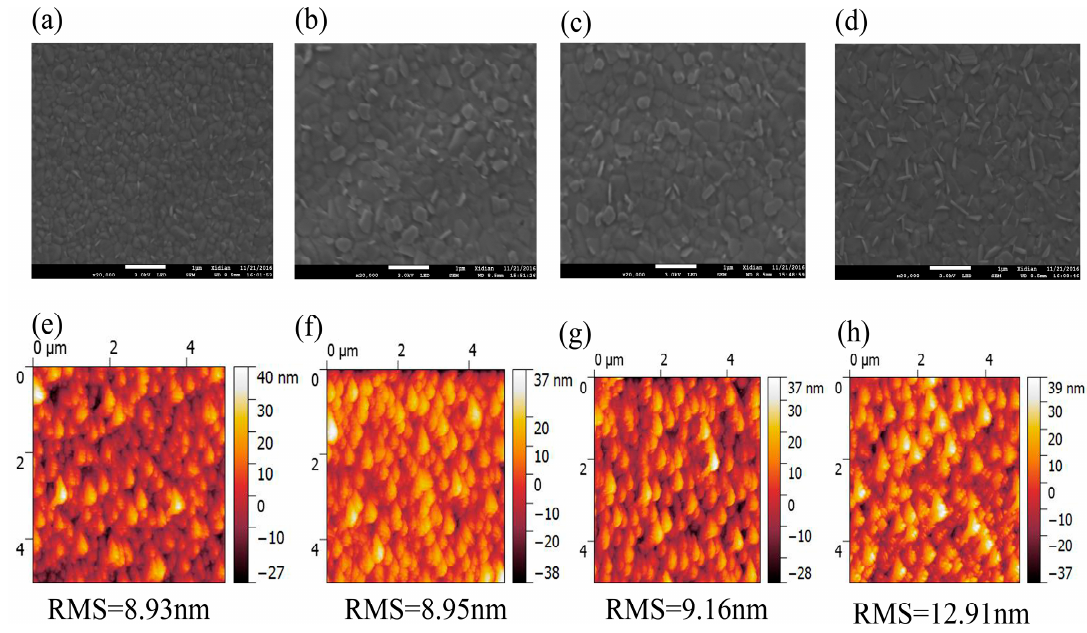
Figure 3. SEM and AFM topography images of MA 0.7 FA 0.3 Pb(I 0.9 Br 0.1 ) 3 perovskite films annealed at 100 °C for 10 ( a , e ), 20 ( b , f ), 30 ( c , g ) and 40 ( d , h ) min. The scale bar in SEM measurements is 1 μ m.